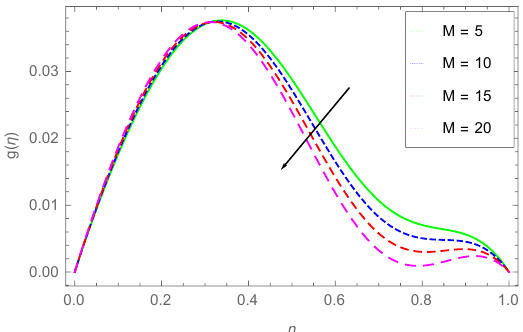
Figure 9. g ( η ) dependence on M